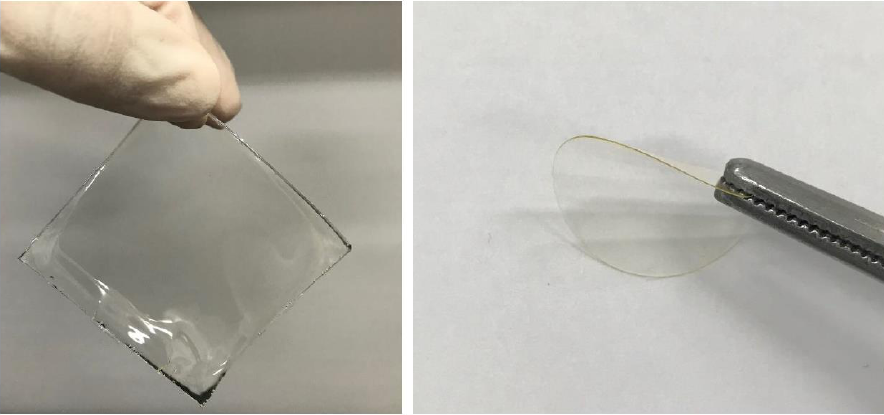
Figure 3. The physical appearance of the SGPEs at room temperature.